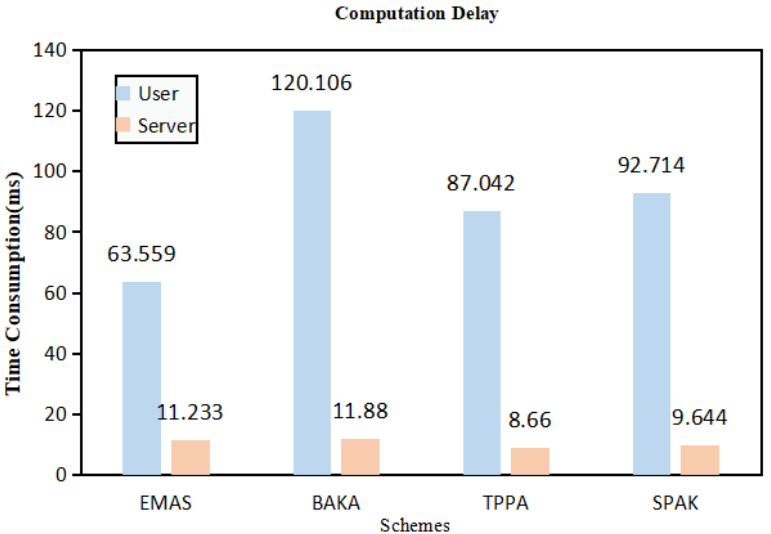
Figure 6. Computation delay of each scheme in authentication phase.